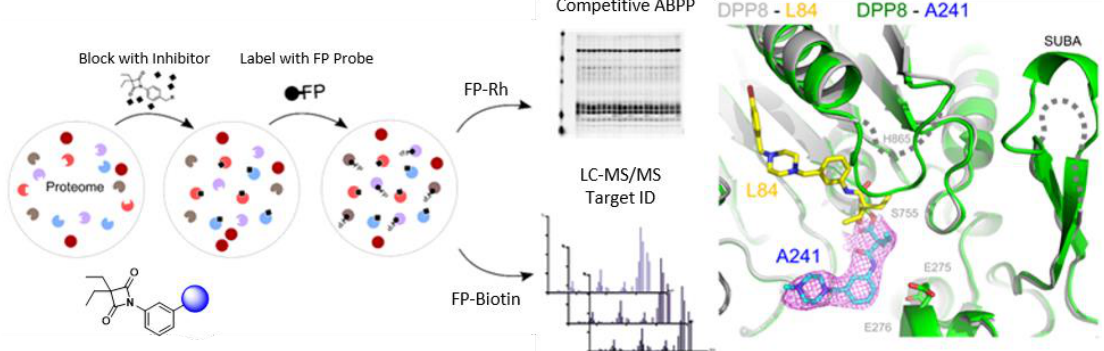
Figure 1. Identification of DDP8/9 inhibitors using activity-based protein profiling.